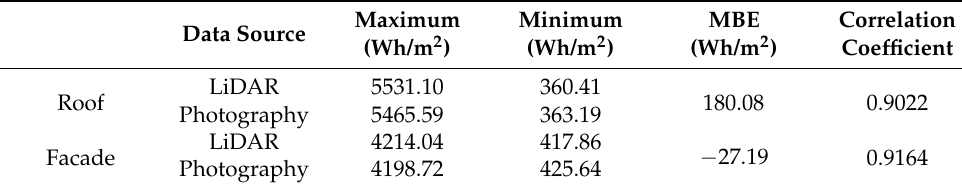
Table 4. Comparison of the solar irradiance for LiDAR and photogrammetric mesh models. Maximum Data Source (Wh/m 2 )